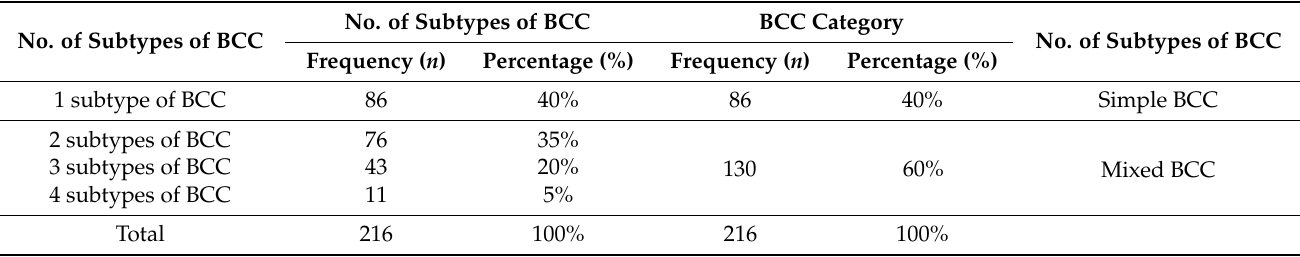
Table 2. Distribution of the number of histopathological subtypes of BCC